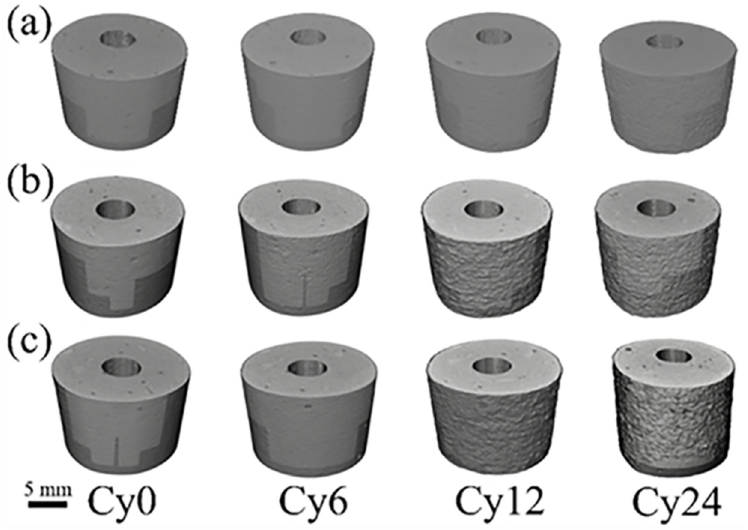
Figure 6. Reconstructed 3D image of the three specimens after different drying–immersion cycles: ( a ) Sc; ( b ) Ss; ( c ) Scs.